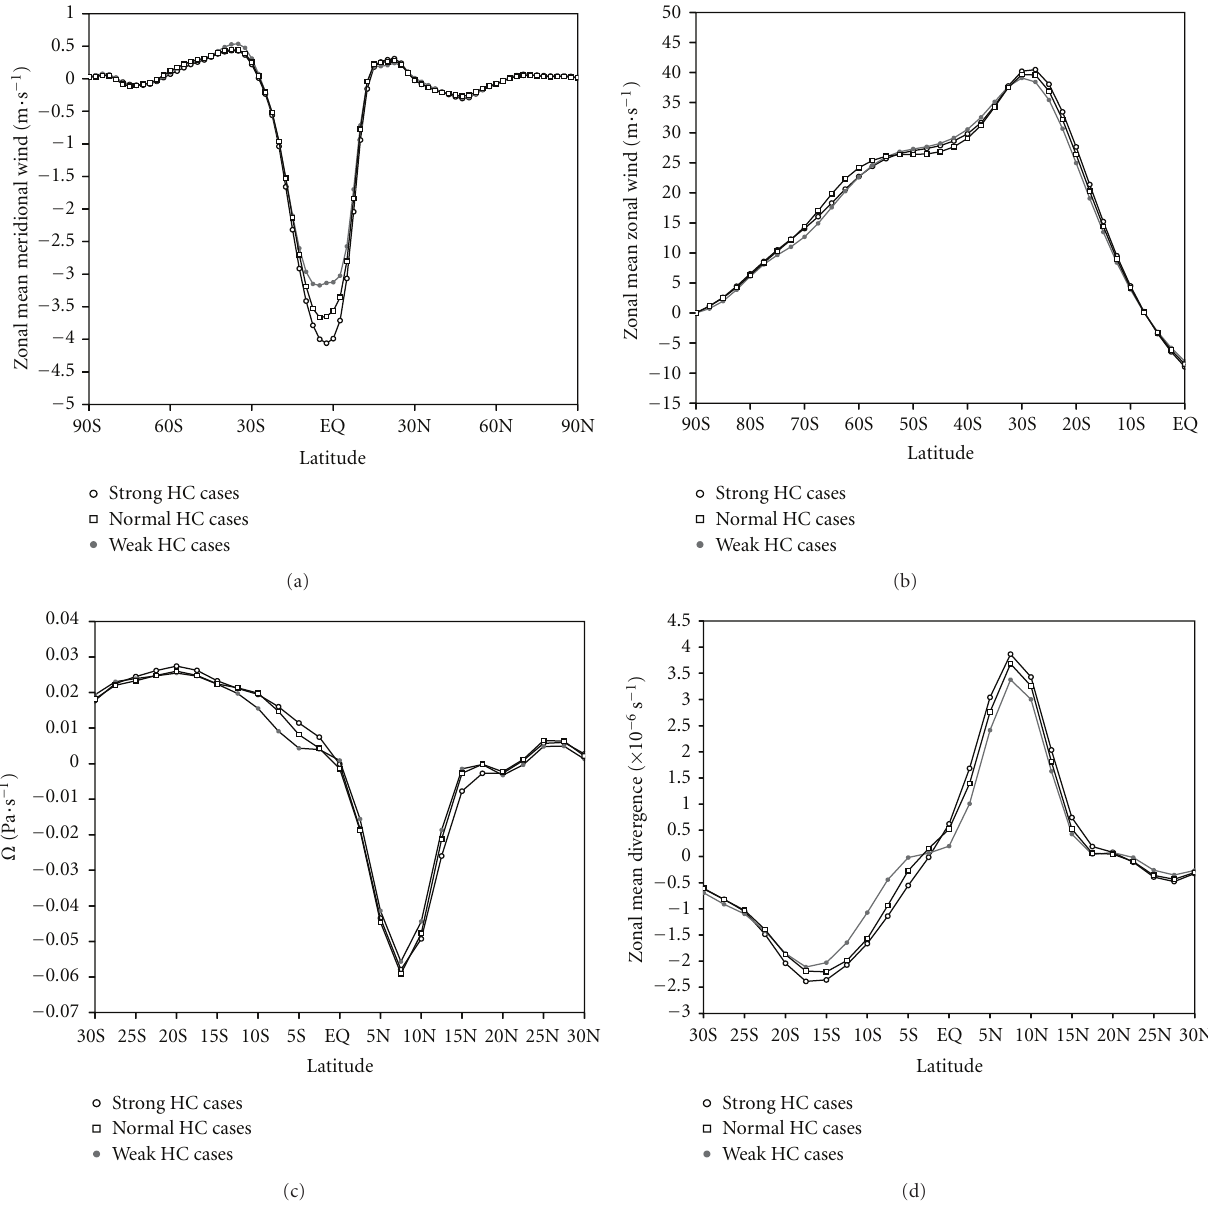
Figure 1: Zonal mean variables for strong, normal, and weak HC cases: (a) meridional wind (ms − 1 ) at 200 hPa, (b) zonal wind (ms − 1 ) at 200hPa, (c) omega (Pa/s) at 500hPa, and (d) divergence ( × 10 − 6 s − 1 ) at 200 hPa.